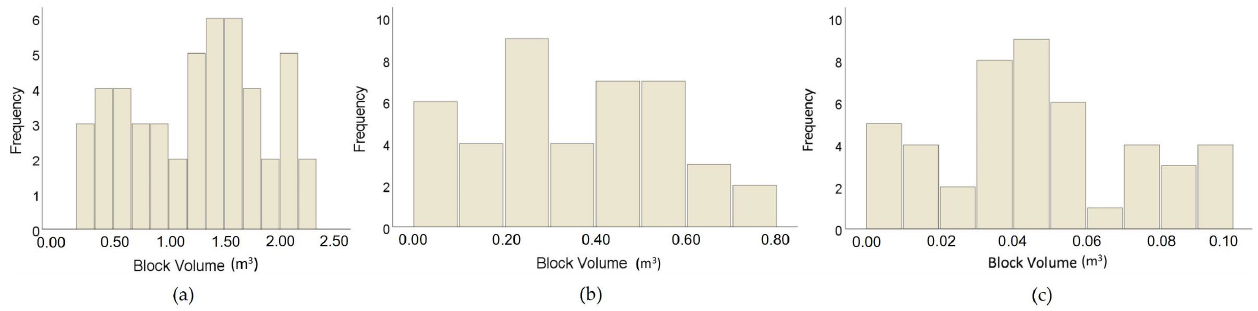
Figure 8. Rock block volume frequency histograms for the limestone rock masses of ( a ) Pantokratoras, ( b ) Vigla, and ( c ) Paxos.